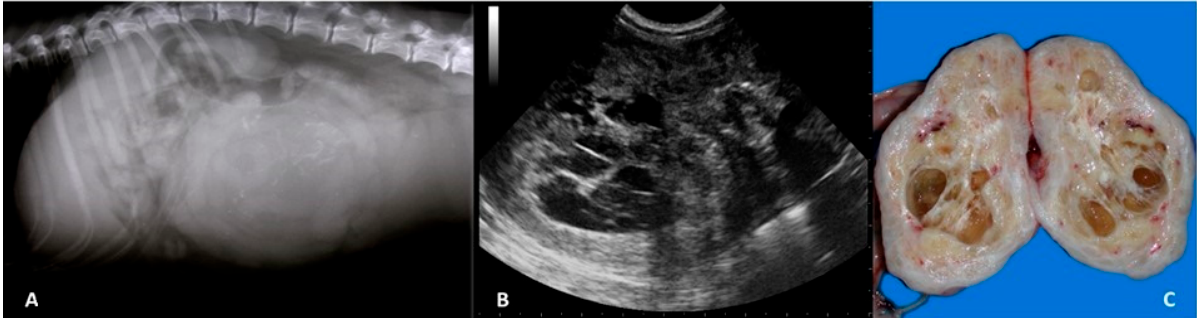
Figure 2. ( A ) Right lateral abdominal radiograph of an 11-year-old pointer female dog with a rounded, ill-defined soft-tissue opacity with mineralised areas at the level of midventral abdomen, displacing the small intestine cranially and the colon dorsally. ( B ) The sagittal ultrasound image shows an inhomogeneous echotexture with multiple, irregular hypoechoic areas with echogenic foci, representing dystrophic mineralisation. ( C ) Gross features of uterine leiomyoma in which multiple large and small cavities are visible representing areas of necrosis and haemorrhage.